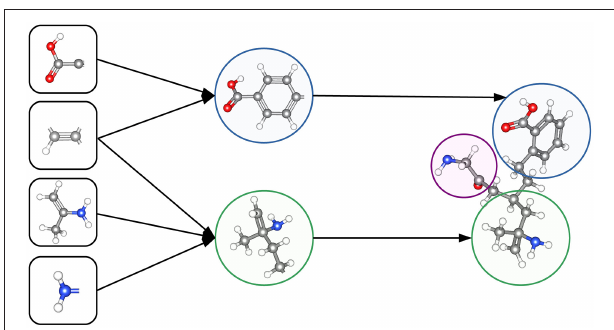
FIGURE 3 | Representation of a toxicophore by hierarchically related features. Simple features share chemical properties coded as reactive centers. Combining reactive centers leads to toxicophores that represent specific toxicological